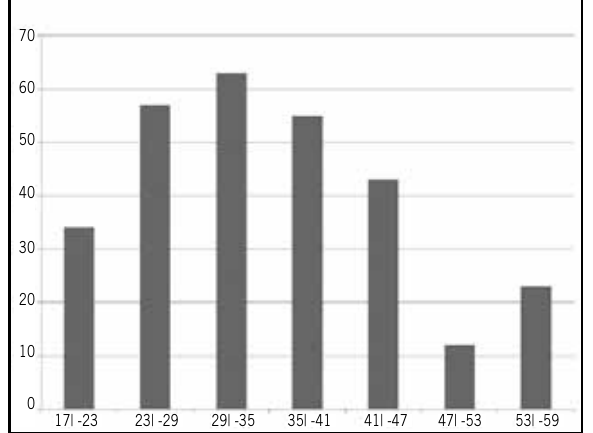
Figura – Frequência da idade das pacientes neste estudo Frequência positiva e negativa das amostras analisadas em relação Tabela